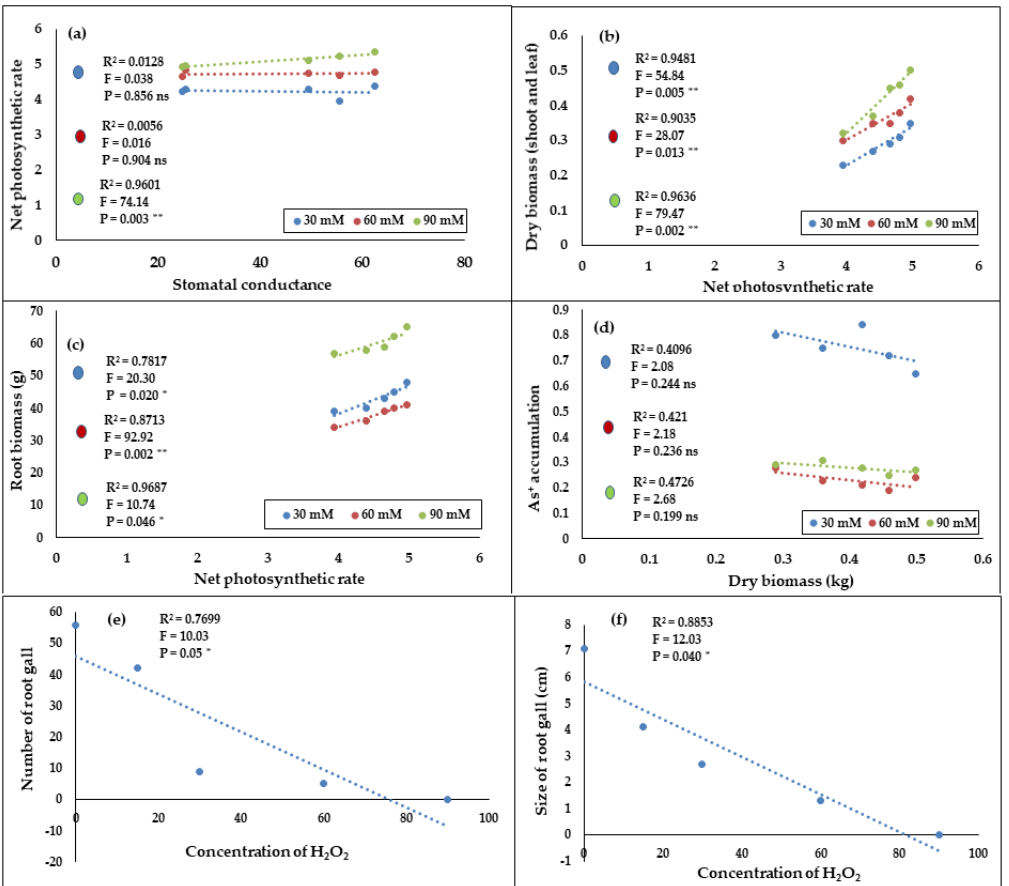
Figure 9. Relationship between different physiological parameters of H 2 O 2 treated plants. ( a ) Stomatal conductance (mmol/m 2 /s) with net photosynthetic rates ( μ mol/m 2 /s); ( b ) Net photosynthetic rate ( μ mol/m 2 /s) with dry biomass content; ( c ) Net photosynthetic rate ( μ mol/m 2 /s) with root biomass (g); ( d ) Dry biomass (kg) with As + accumulation ( μ g/g) in H 2 O 2 treated plants; ( e ) Number of root gall with H 2 O 2 concentration (mM), and ( f ) Root gall size with H 2 O 2 concentration (mM). ***, **, and * indicate significance at p = 0.020 < 0.001, p = 0.020 < 0.01, and p = 0.020 < 0.05, respectively. The value of linear regression slope was obtained according to the homogeneity test of regression coefficient.